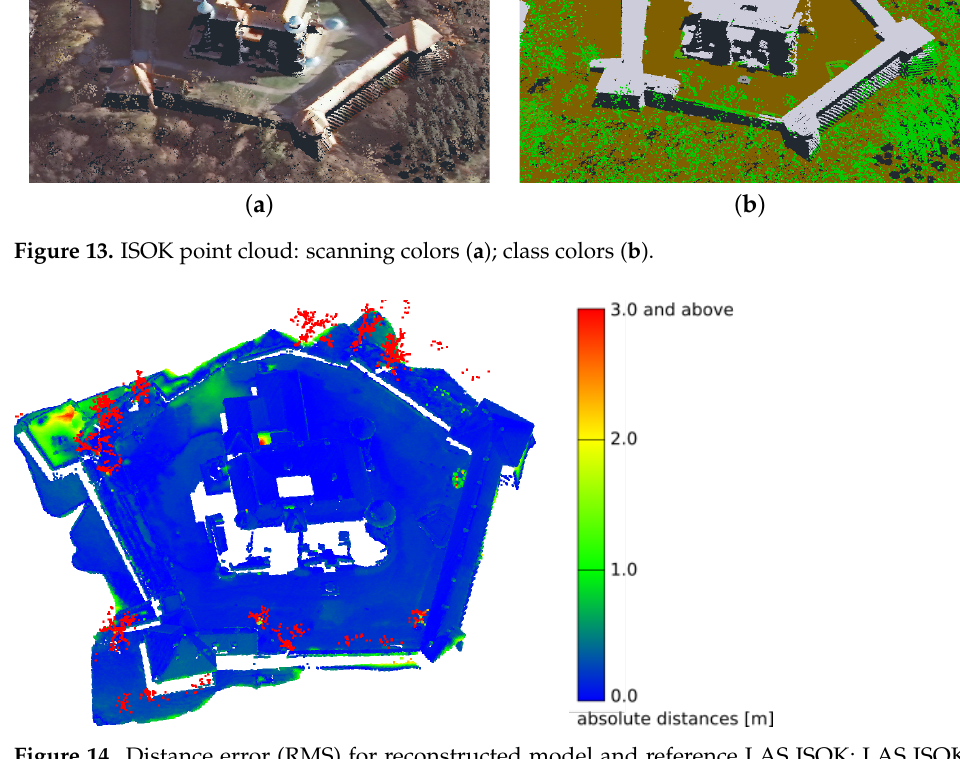
Figure 14. Distance error (RMS) for reconstructed model and reference LAS ISOK: LAS ISOK to reconstructed model—point-to-mesh